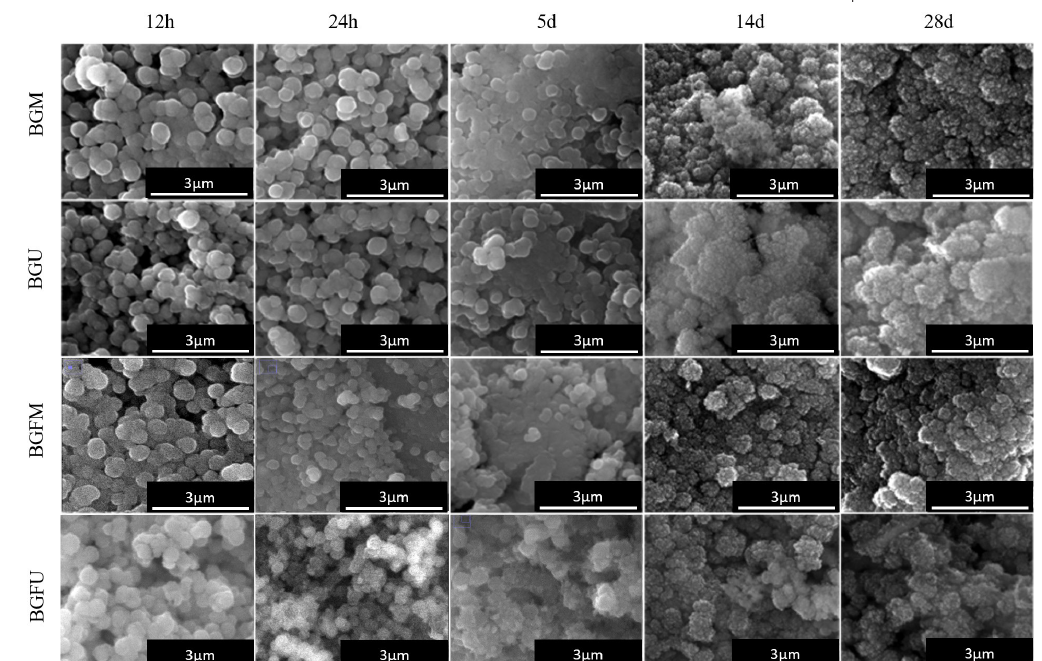
Figure 7. SEM micrographs of the surfaces of the BGM, BGU, BGFM and BGFU after incubation in SBF for 12 h, 24 h, 5 d, 14 d and 28